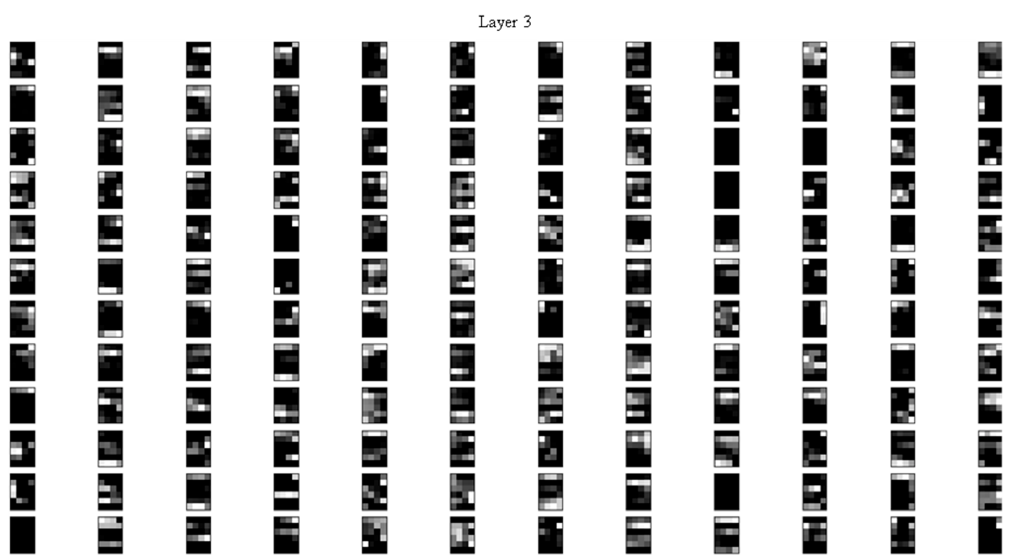
Figure A6. Resultant feature map obtained with the 1st hyper parameter combination in Table 3.